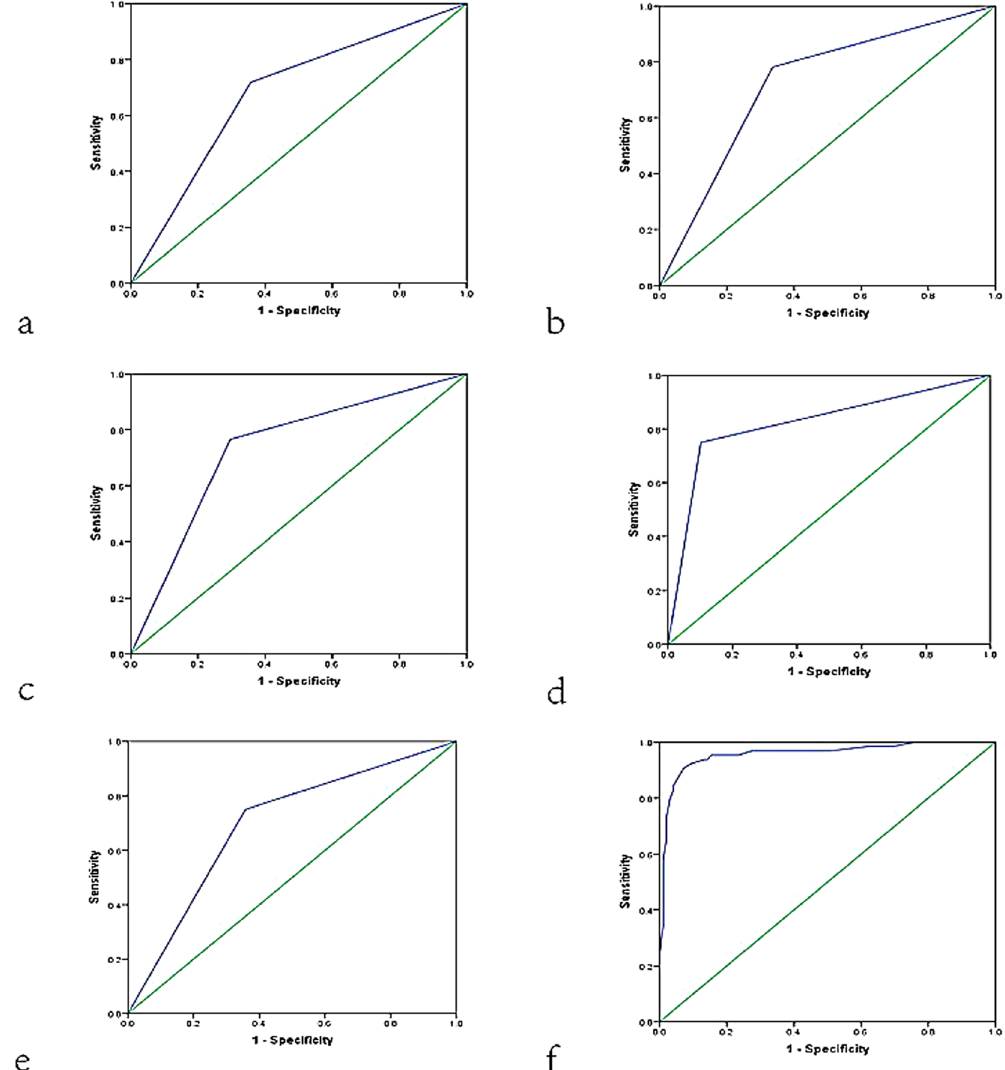
Figure 5. Receiver operating characteristic (ROC) curves of ( a ) the lesion size ≥ 20 mm (AUROC = 0.681), ( b ) taller than wide shape (AUROC = 0.722), ( c ) VTI score ≥ 5 (AUROC = 0.735), ( d ) histological grade III (AUROC = 0.824), ( e ) C-erbB-2 positive (AUROC = 0.696), and ( f ) the predictive equation (AUROC = 0.958) for prediction of axillary lymph node metastasis